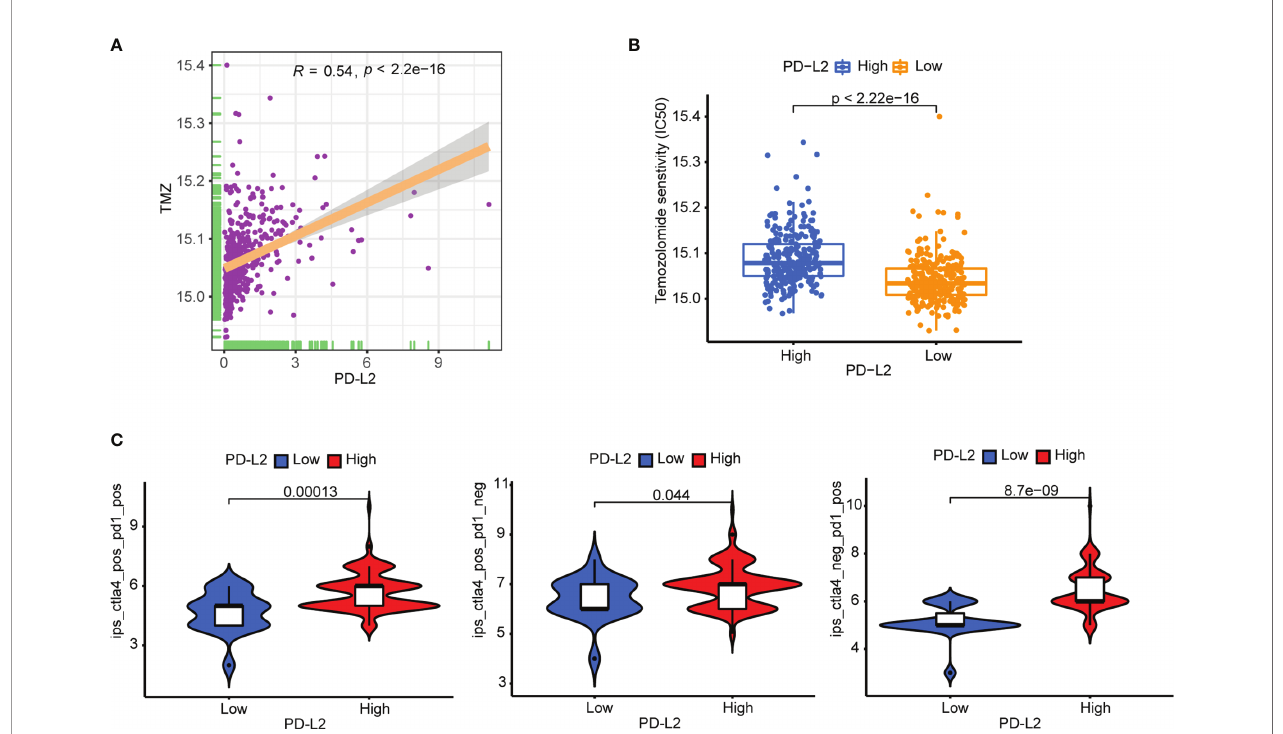
FIGURE 8 | Therapeutic sensitivity prediction to immunotherapy and TMZ-based chemotherapy in the TCGA cohort. (A) PD-L2 was signi fi cantly positively correlated with the TMZ-based chemotherapy. (B) The low-PD-L2 expression patients showed a more sensitive response to TMZ-based chemotherapy based on the estimated IC50. (C) Patients with high PD-L2 expression had higher immunophenoscores (IPS) in three subgroups: CTLA-4 positive PD-1 positive, CTLA-4 negative PD-1 positive, and CTLA-4 positive PD-1 negative. TMZ, temozolomide; IC50, half-maximal inhibitory concentration; IPS,